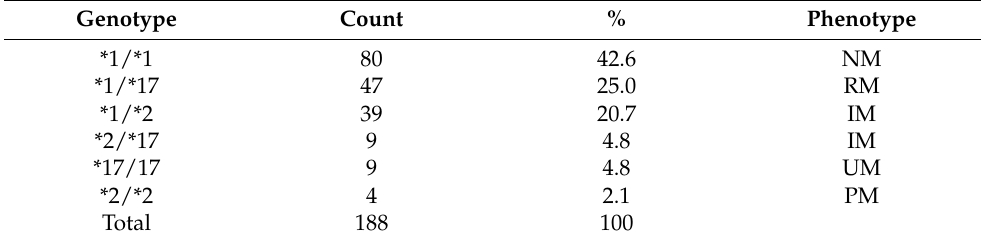
Table 4. Prevalence of CYP2C19 genotypes in a Spanish population.